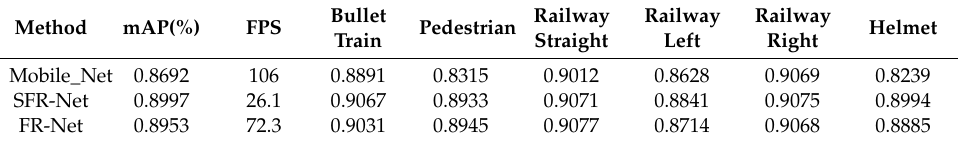
Table 5. Performance of various designs. All of the models are trained on the railway traffic dataset.